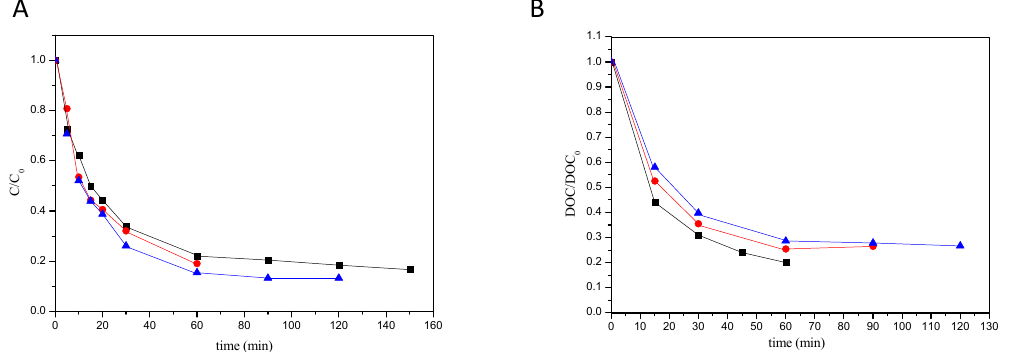
Figure 8. ( A ) Effect of illuminated volume on the degradation efficiency of simulated wastewater containing 40 mg L − 1 CLPR in the presence of the photo ‐ Fenton reagent (7 mg L − 1 Fe 3+ , 100 mg L − 1 H 2 O 2 , pH: 3.0): [ ■ ] V= 5 L, [ ● ] V = 8 L, [ ▲ ] V = 3 L. Intensity of incident UV ‐ A light 3.39 mW cm − 2 ; ( B ) mineralization of simulated wastewater containing 40 mg L − 1 CLPR in the presence of the photo ‐ Fenton reagent (7 mg L − 1 Fe 3+ , 100 mg L − 1 H 2 O 2 , pH: 3.0): [ ■ ] V = 5 L, [ ● ] V= 8 L, [ ▲ ] V = 3 L. Intensity of incident UV ‐ A radiation: 3.39 mW cm − 2 .